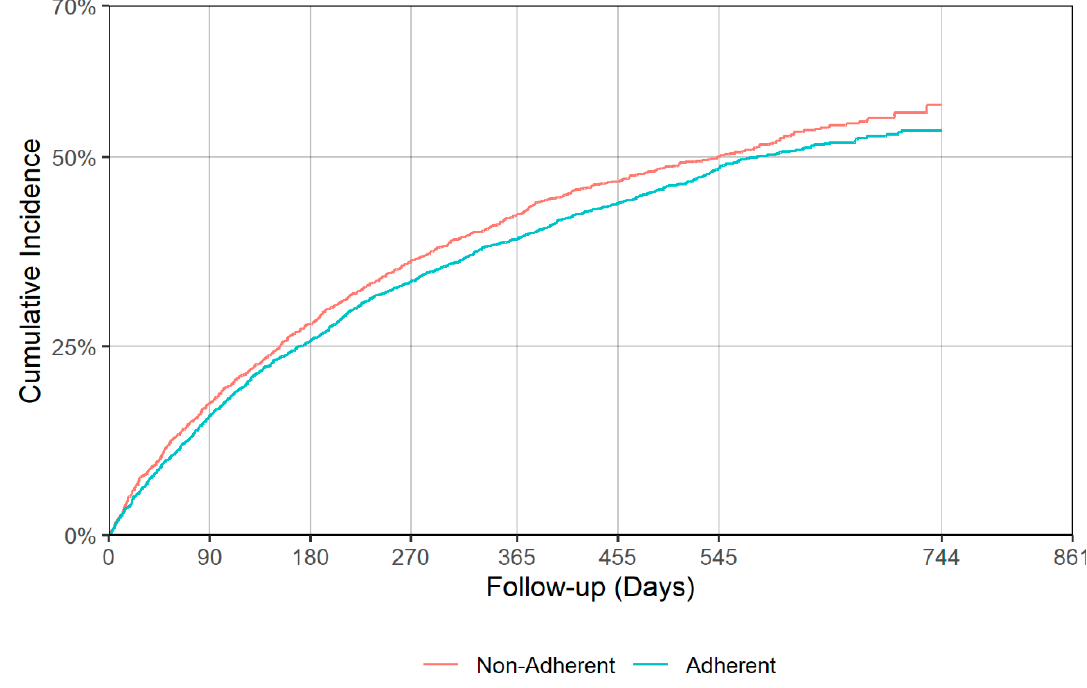
Figure 6. IPT-weighted cumulative incidence function of all-cause hospitalization, adjusting for death before hospitalization as a competing risk (continuation phase). Modified Gray’s test p = 0.126.